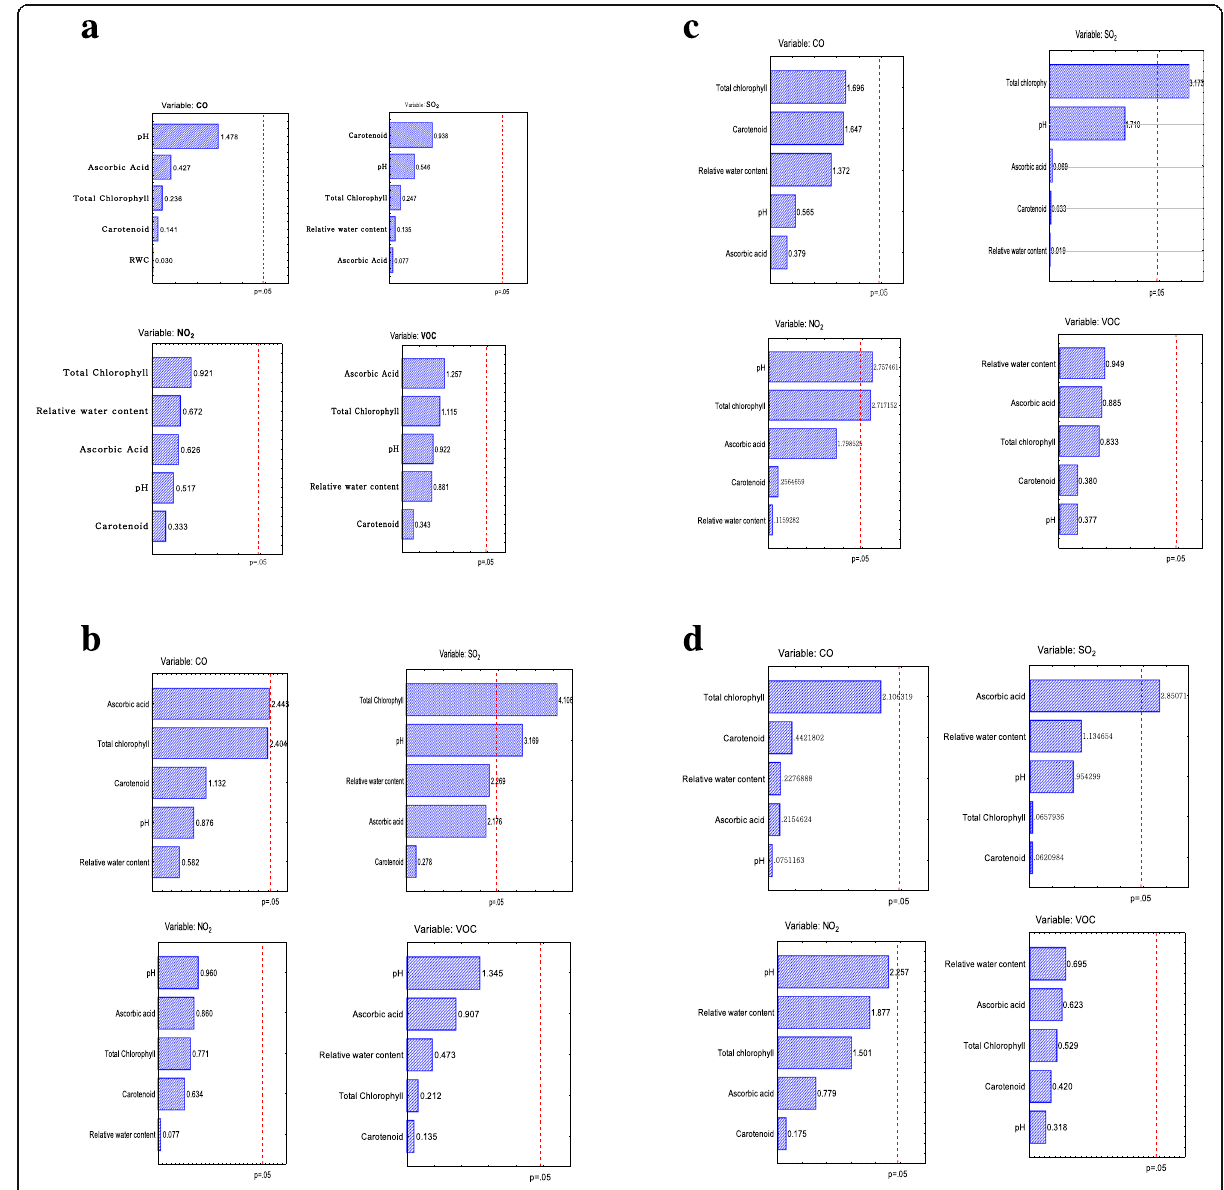
Fig. 2 a Pareto chart of t values between ambient air quality and biochemical parameters of Terminalia catappa . b Pareto chart of t values between ambient air quality and biochemical parameters of Mangifera indica . c Pareto chart of t values between ambient air quality and biochemical parameters of Ficus platyphylla . d Pareto chart of t values between ambient air quality and biochemical parameters of Polyalthia